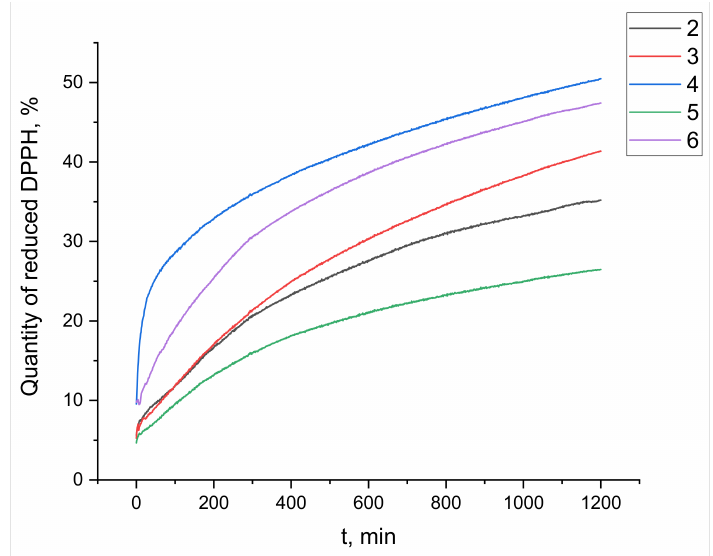
Figure 2. The change of reduced DPPH quantity in a test solution of complexes 2 – 6 during 20